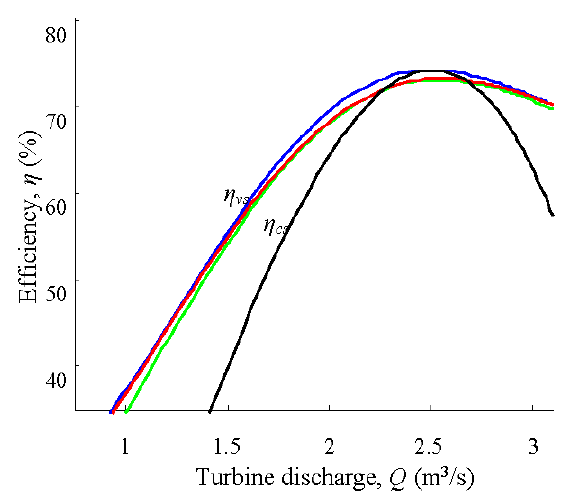
Figure 11. Turbine efficiency as a function of turbine discharge for the optimal measured operation curve (solid blue line), operation curves defined by the simplified formula (solid green line), corrected formula (solid red line) and constant speed operating curve (solid black line).